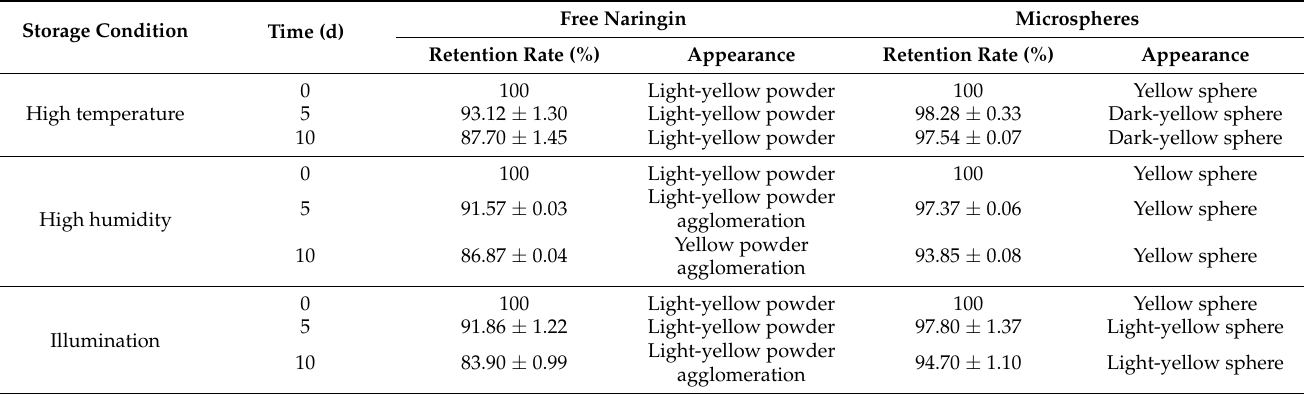
Table 2. Stability of naringin microspheres and free naringin under different conditions ( n =